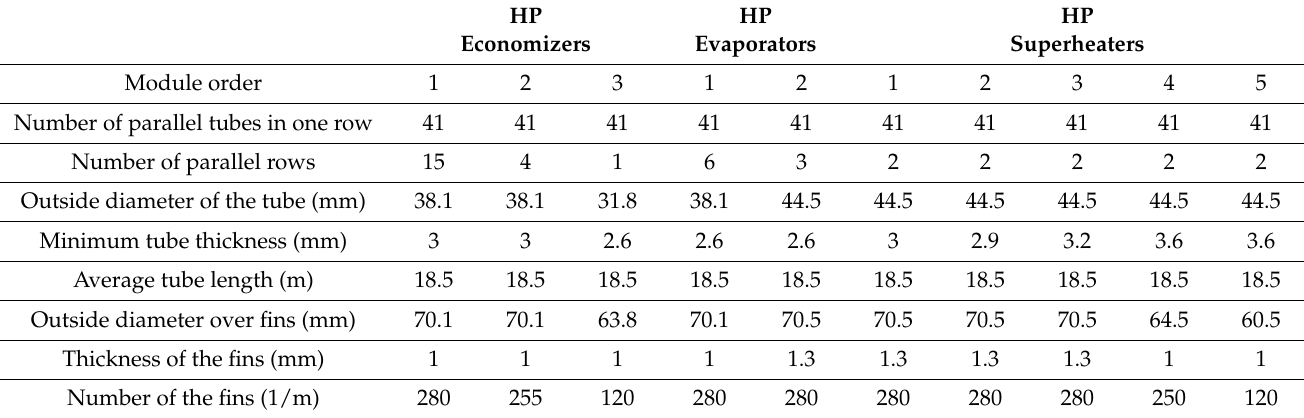
Table 1. Initialization of the HRSG high-pressure heating modules.